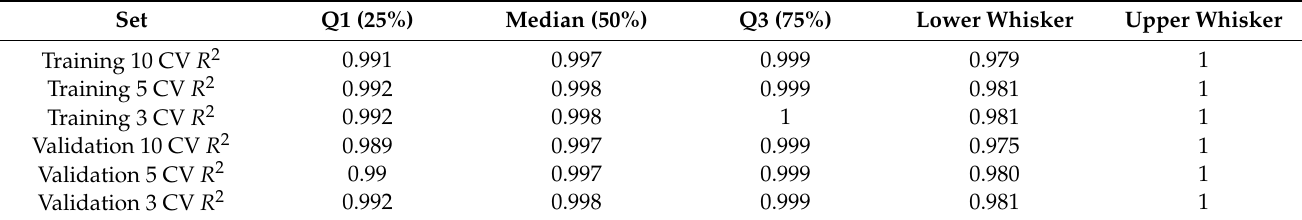
Table 4. Values of the characteristic box plot properties from Figure 6.